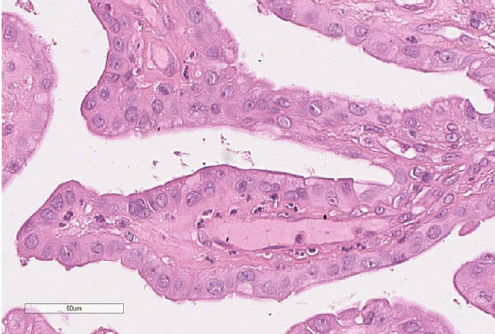
Figure 2: Cystic-looking tumor, with intermixed papillary projections.